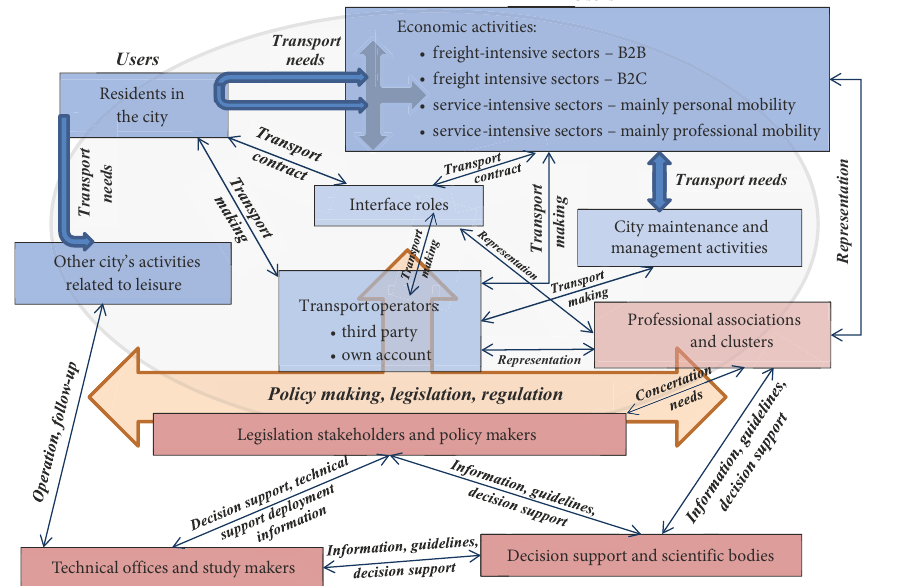
Figure 1. The main stakeholders related to urban transport and their